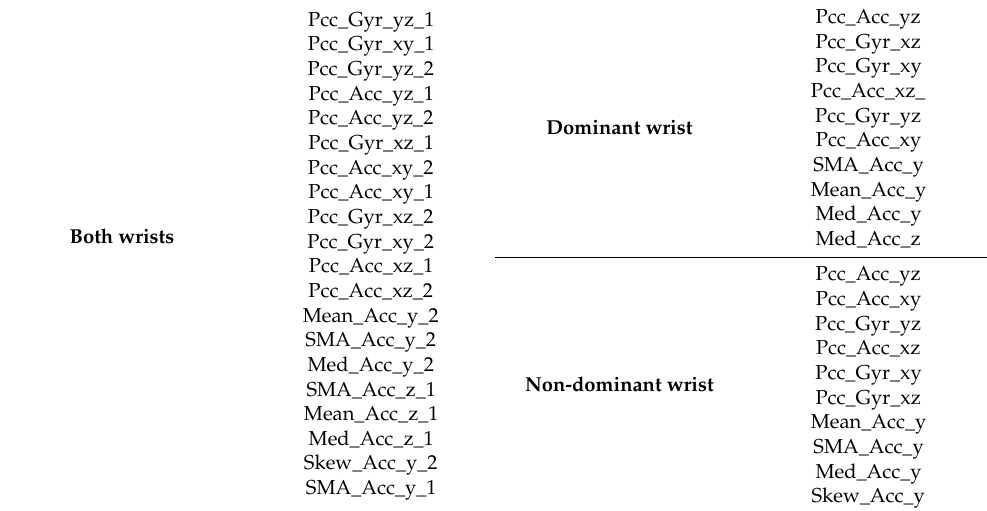
Table A1. Best features selected for both wrists, dominant wrist, and non-dominant